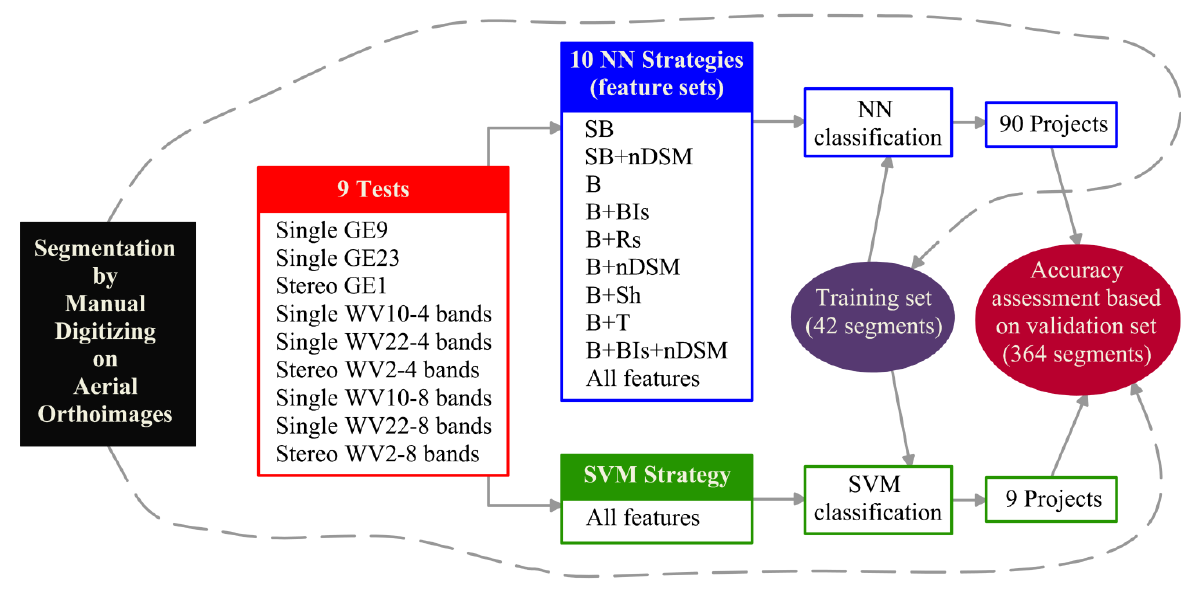
Figure 8. Flowchart of the classification